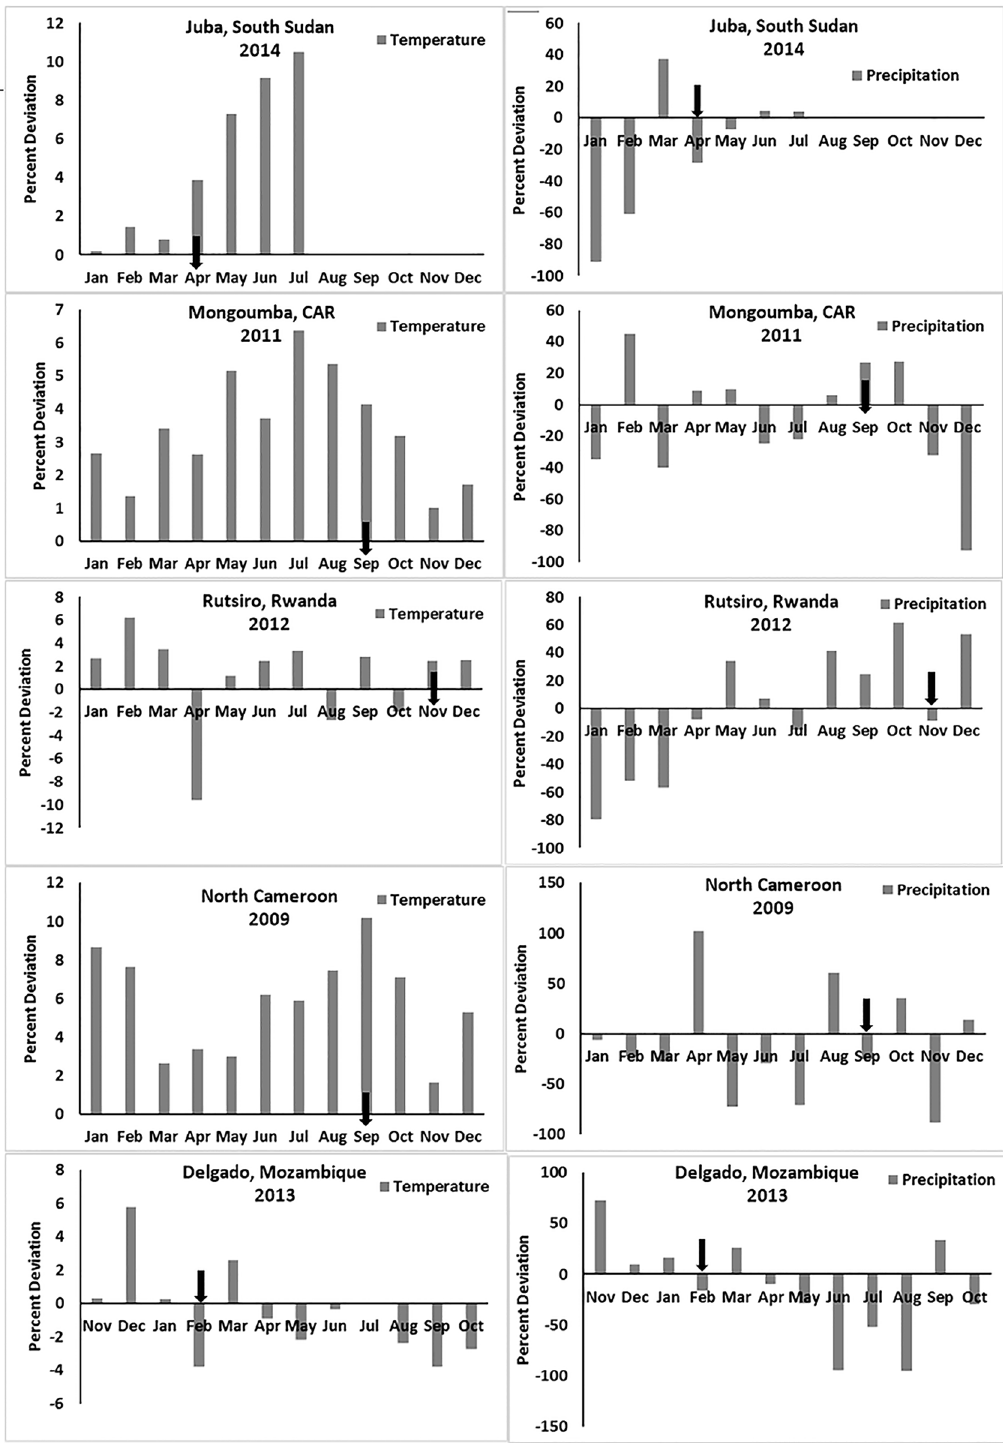
Fig 6. Precipitation and temperature anomalies for five regions in Africa. Black arrows on the x-axis of plots indicates month when cholera was first reported.